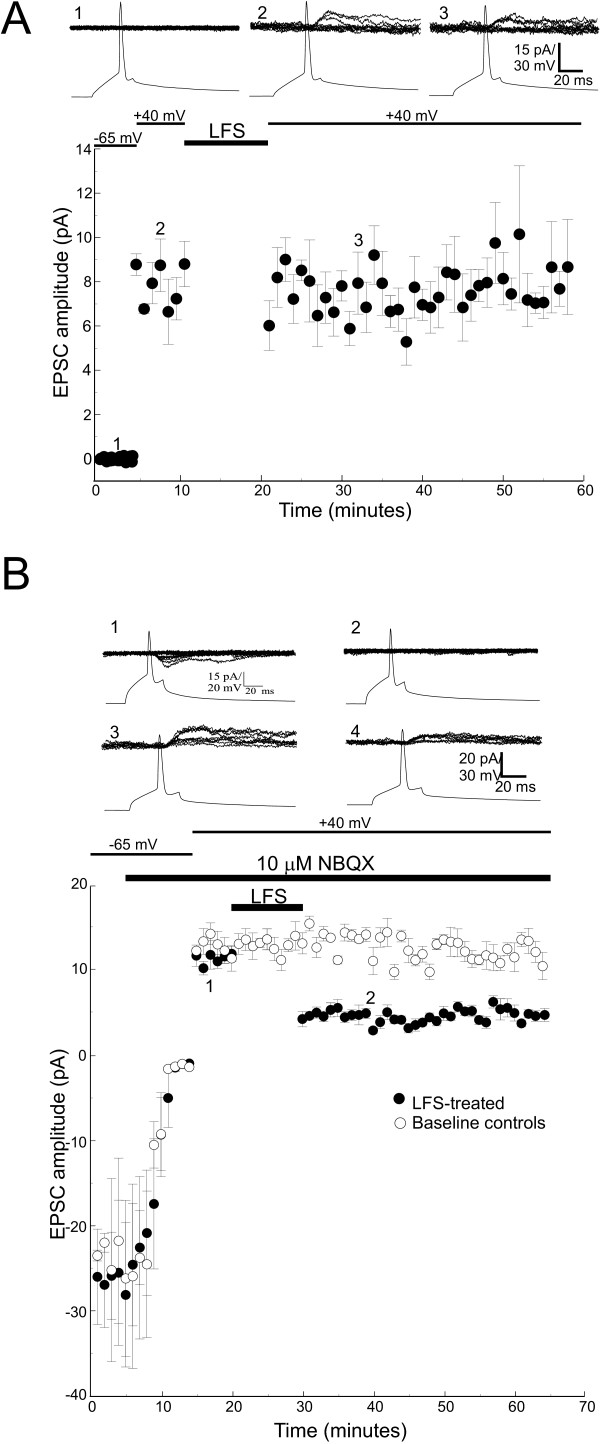
NMDAR-mediated responses are not depressed by low-frequency stimulation (LFS) at silent synapses in synaptically connected pairs of CA3 pyramidal neurons. A. Silent synaptic connections between pairs of CA3 pyramidal neurons [10]showed no synaptic responses when the postsynaptic cell was held at a negative potential (-65 mV). Depolarization of the postsynaptic cell to +40 mV revealed the NMDAR-mediated EPSC of these silent synapses. LFS did not cause any change in this NMDAR-only synaptic transmission (n = 7 pairs). Inset: Each inset shows consecutive postsynaptic traces overlaid, with one example presynaptic action potential. (1) 50 consecutive postsynaptic responses collected from the start of the paired recording, showing no AMPAR-mediated responses at -65 mV. (2). At +40 mV, NMDAR mediated responses are evident. (3) After performing LFS, NMDAR mediated responses are shown at +40 mV. For both (2) and (3), 10 consecutive traces are shown, before LFS (2), and ten minutes after LFS (3). B. The same LFS protocol applied to active synapses does depress the NMDAR-mediated EPSC (n = 6 pairs). After confirmation that a synaptic connection displayed AMPAR-mediated responses, NMDAR EPSCs were isolated by application of 10 μM NBQX. Inset shows ten consecutive postsynaptic traces collected at -65 mV before (1) and after (2) NBQX and +40 mV in NBQX, before (3) and 10 minutes after (4) LFS. An exemplar presynaptic action potential is shown in each case. Closed symbols: LFS-treated, open symbols, no LFS applied.